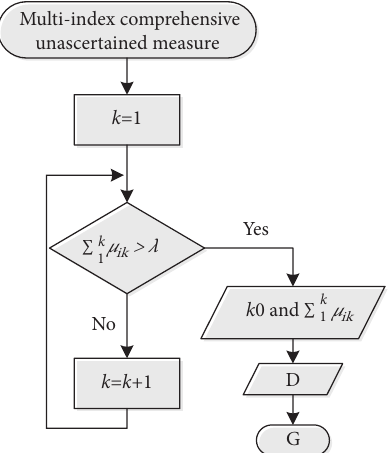
Figure 1: The flow-chart of the modified credible degree